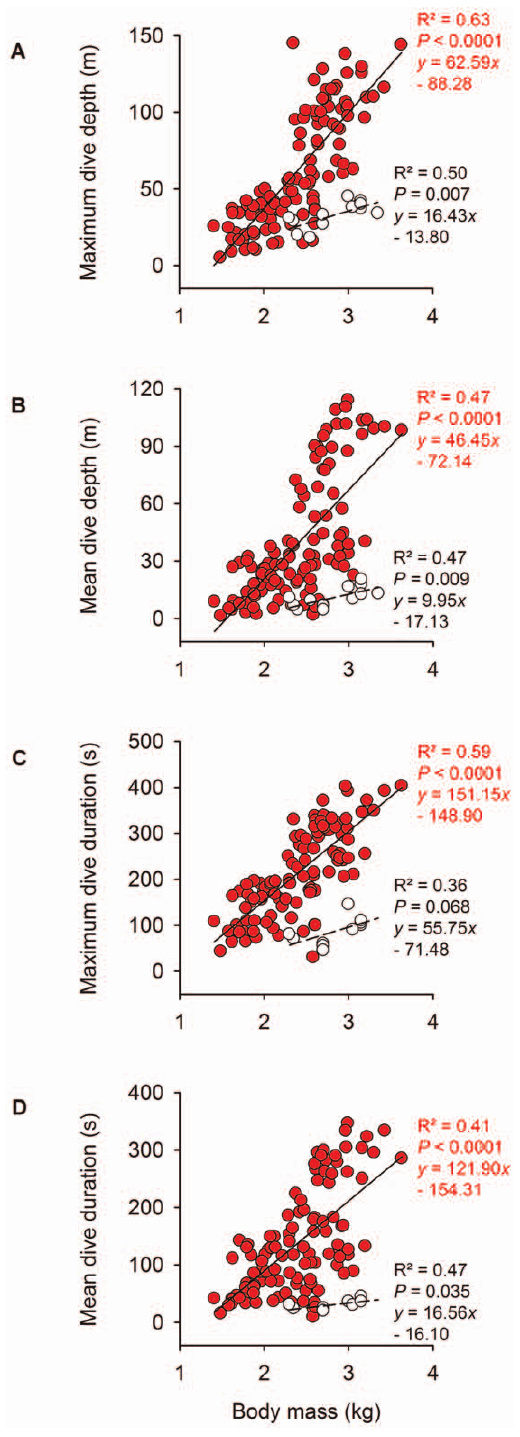
Figure 6. Relationship between body mass and diving capacity in Blue-eyed Shags. Effect of body mass on (A) maximum dive depth, (B) mean dive depth, (C) maximum dive duration and (D) mean dive duration for 110 Blue-eyed Shag individuals from eight colonies. For comparison, data is provided for 13 birds from a species outside the Blue-eyed Shag complex (white circles, dashed line), the Japanese Cormorant Phalacrocorax capillatus (data from [76]).